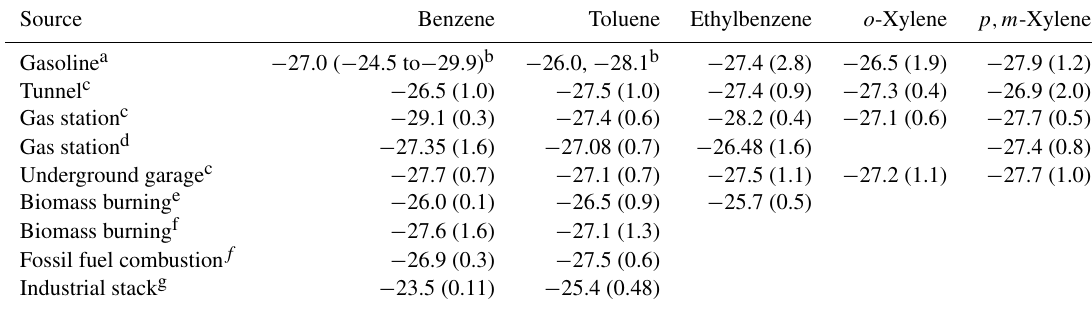
Table 8. Average stable carbon isotope ratios ( δ 13 C, ‰) of major sources of ambient VOC. The sample standard deviation is given in